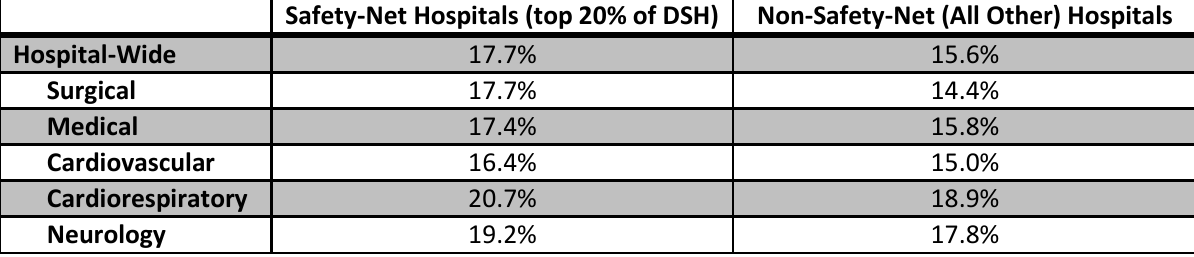
Table 5.8. Risk-Standardized Readmission Rates by Safety-Net Status